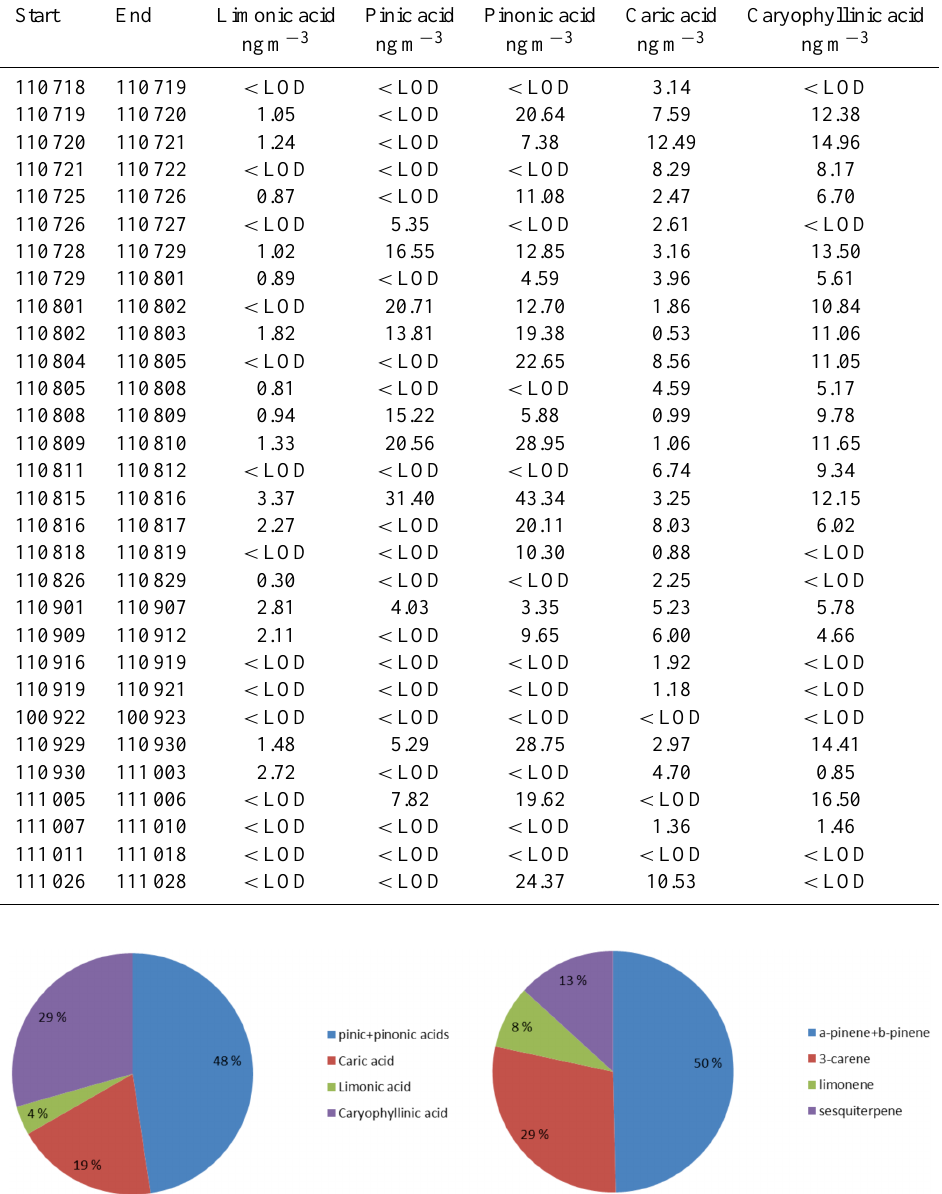
Figure 3. Relative contributions of terpenoic acids in summer (left) and average terpenoid emission fluxes (right) from middle boreal zone forests in summer from Tarvainen et al.